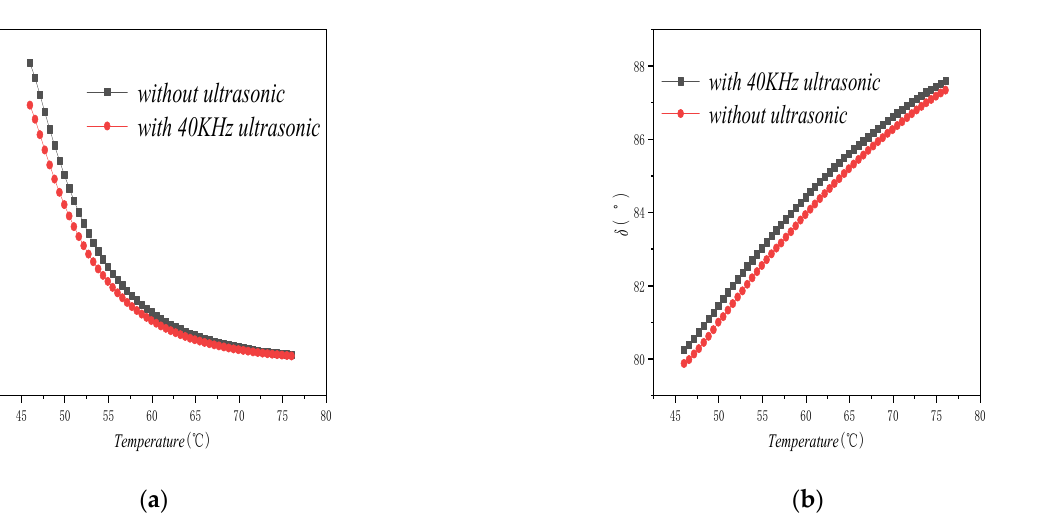
Figure 14. Effect of temperature on complex shear modulus and phase angle of nanobitumen (46– 76 °C). ( a ) complex modulus G*; ( b ) phase angle δ